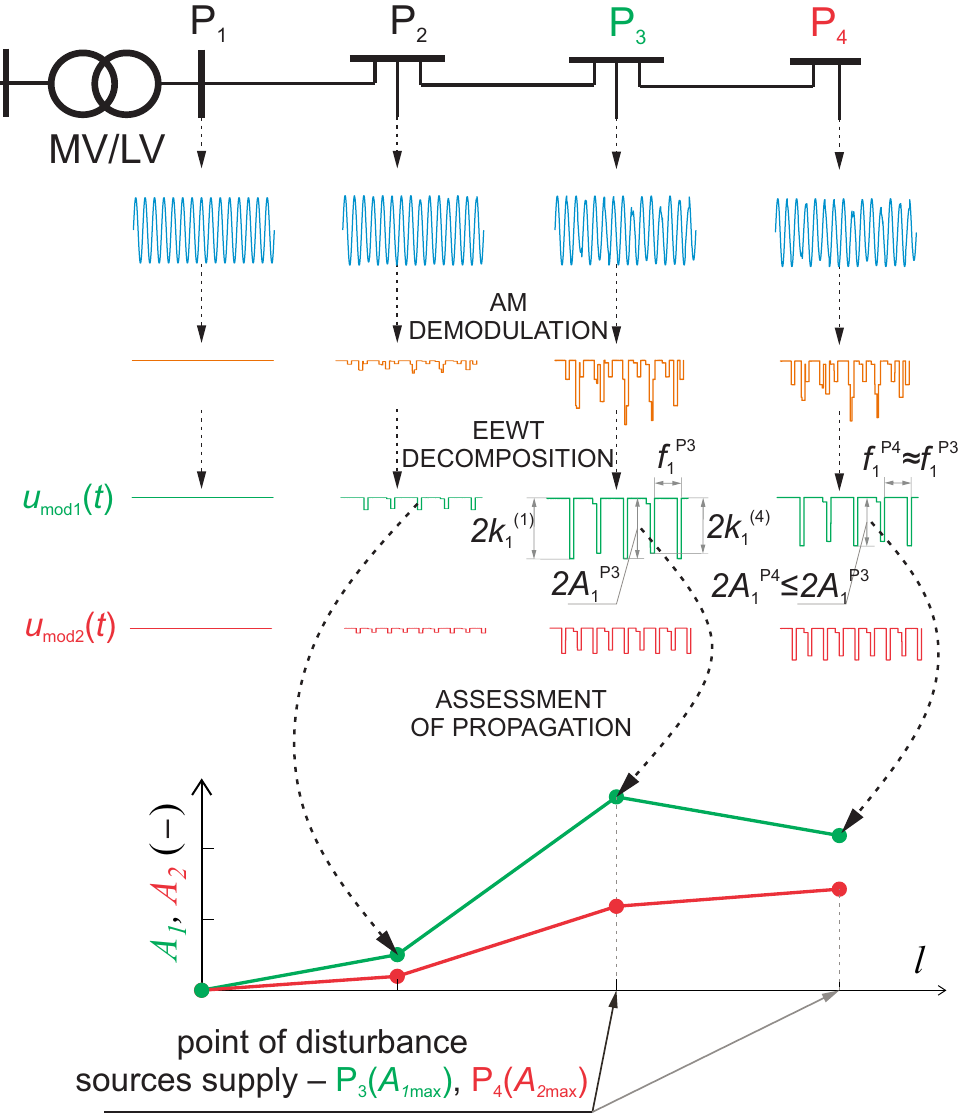
Figure 5. Graphic representation of the process of selective identification of supply point of voltage fluctuation